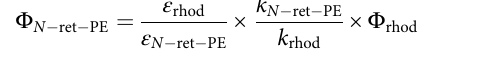
(Table 1). Total retinaldehydes, representing mainly rhodopsin, contained predominantly 11cRAL, while N- ret-PE contained higher fractions of 13cRAL and atRAL (Table 1) re fl ecting the much lower thermal stability of N- ret-PE versus rhodopsin 21 . By combining the retinaldehyde isomers in N- ret-PE, we quantitated total N- ret-PE per dark-adapted mouse retina as 37 pmol (Table 1), or approximately 7% of the total retinaldehyde pool.